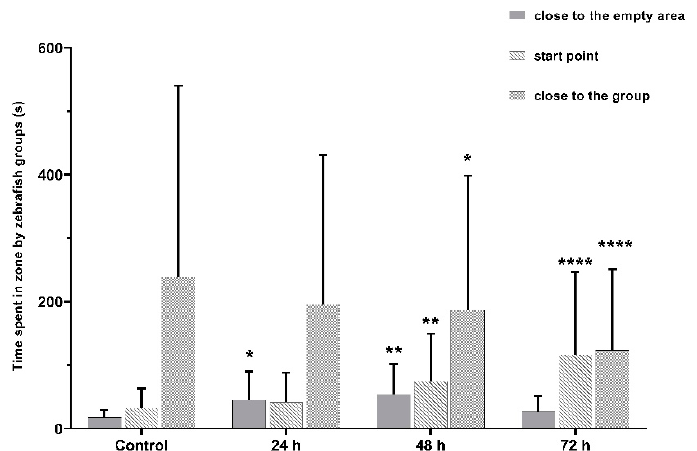
Figure 7. The amount of time spent by zebrafish groups during the social interaction test. Group 1, control ( n = 30); Group 2, group exposed for 24 h to VPA ( n = 24); Group 3, group exposed for 48 h to VPA ( n = 24); and Group 4, group exposed for 72 h to VPA ( n = 22). The social behavior was measured as the time spent by fish in the close to the group area. The data is represented as average ± SEM. Anova and Tukey post-hoc tests, p < 0.05 was considered to be significant. The experimental groups were compared to control group, where * p < 0.05, ** p < 0.01 and **** p < 0.0001.